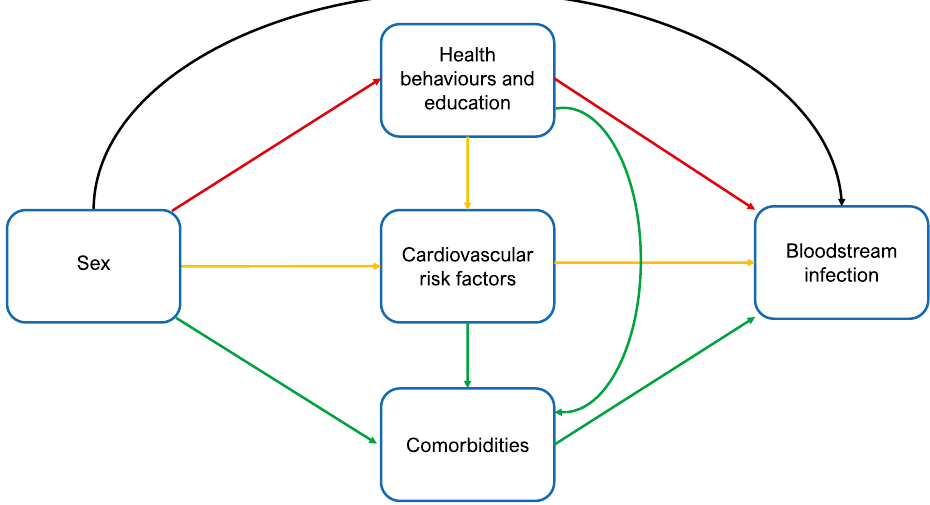
Figure 1. Mediation analysis. Diagram of the direct and indirect (i.e., mediated) effects of sex on bloodstream infection . The black arrow represents the natural direct effect of the association. Red arrows represent model 1, proportion mediated by health behaviours and education attainment. Yellow arrows represent model 2, proportion mediated jointly by health behaviours, education, and cardiovascular risk factors. Green arrows represent model 3, proportion mediated jointly by health behaviours, education, cardiovascular risk factors and comorbidities. Model 1) Smoking, alcohol use and educational attainment. Model 2) Systolic blood pressure, non-high-density lipoprotein cholesterol and Body Mass Index. Model 3) Cardiovascular disease, chronic kidney disease, diabetes, history of cancer, and chronic lung